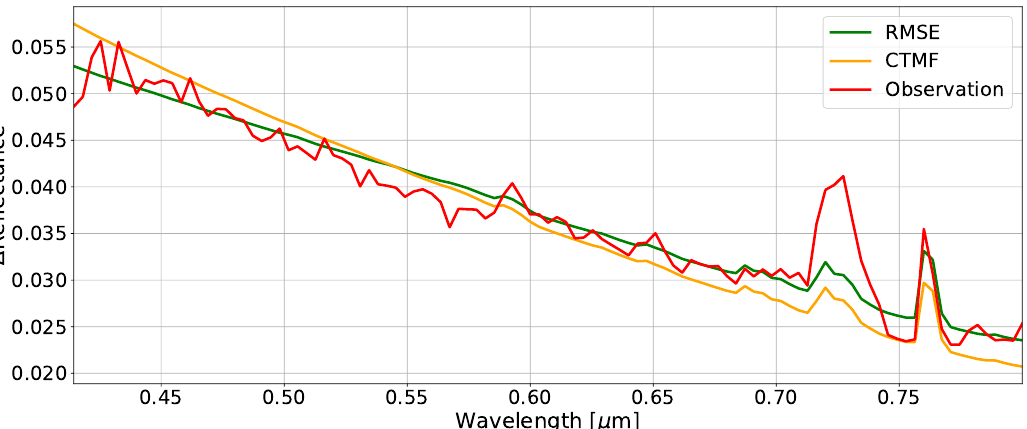
Figure 7. Example of difference between spectra acquired inside and outside the plume over water surface (red), compared to the best differential model from the CTMF (orange) and RMSE (green)